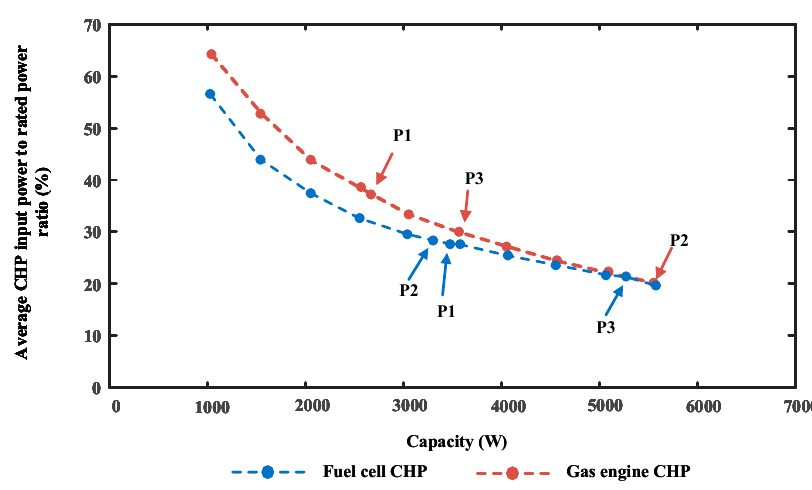
Figure 16. Average CHP input power to rated power ratio against CHP installation capacity.